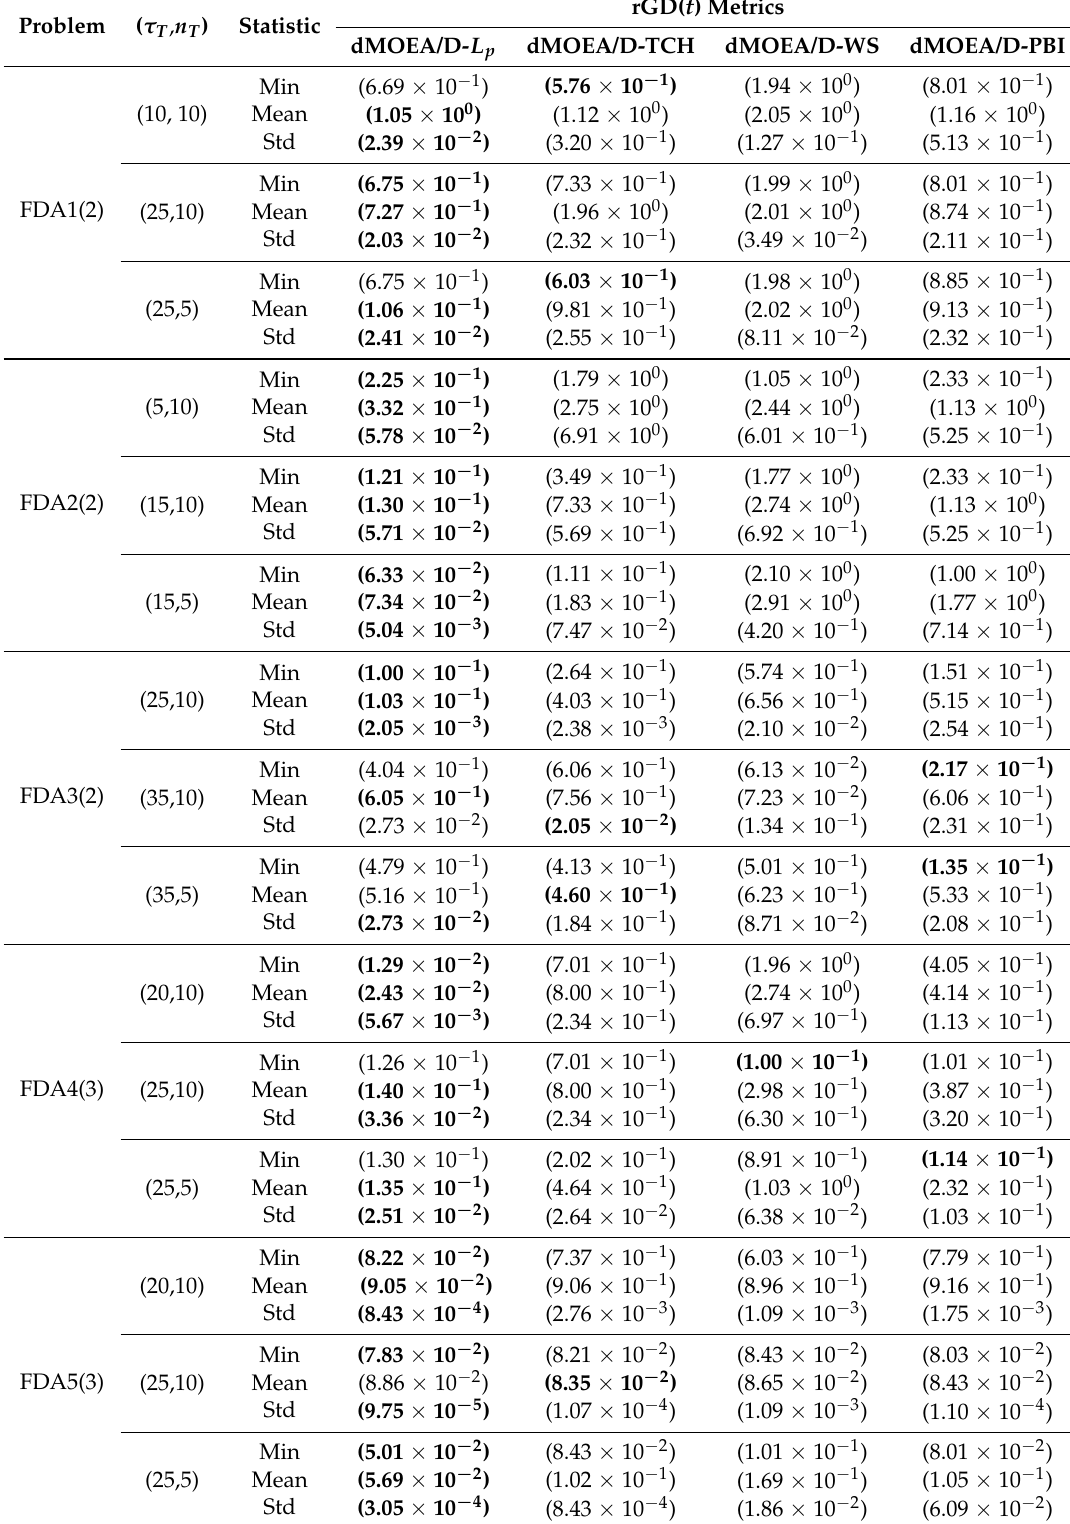
Table 4. The best, mean, and standard deviation of rGD( t ) metric values obtained by dMOEA/D- L p and the other versions of dMOEA/D on test problems based on 30 independent runs. The best performance of each metric value is marked in bold. dMOEA/D-PBI: dMOEA/D with the PBI decomposition approach; dMOEA/D-TCH: dMOEA/D with the Tchebycheff decomposition approach; dMOEA/D-WS: dMOEA/D with the weighted sum decomposition